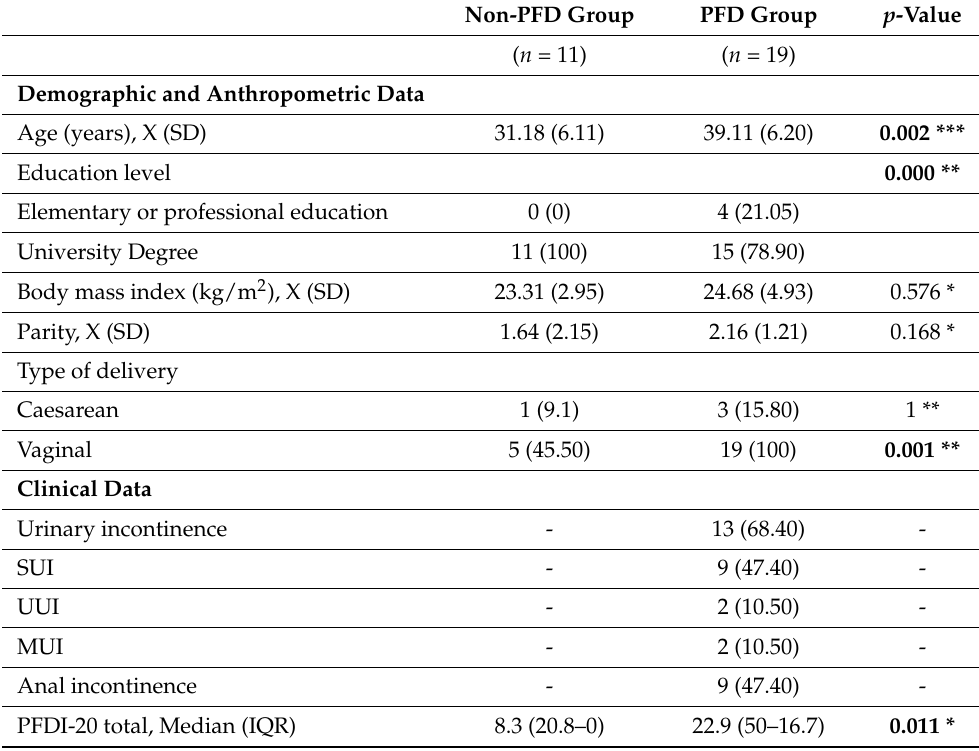
Figure 2. Flow diagram of participants. Table 1. Demographic and clinical characteristics of participants. Values are numbers (percentages) unless stated otherwise.